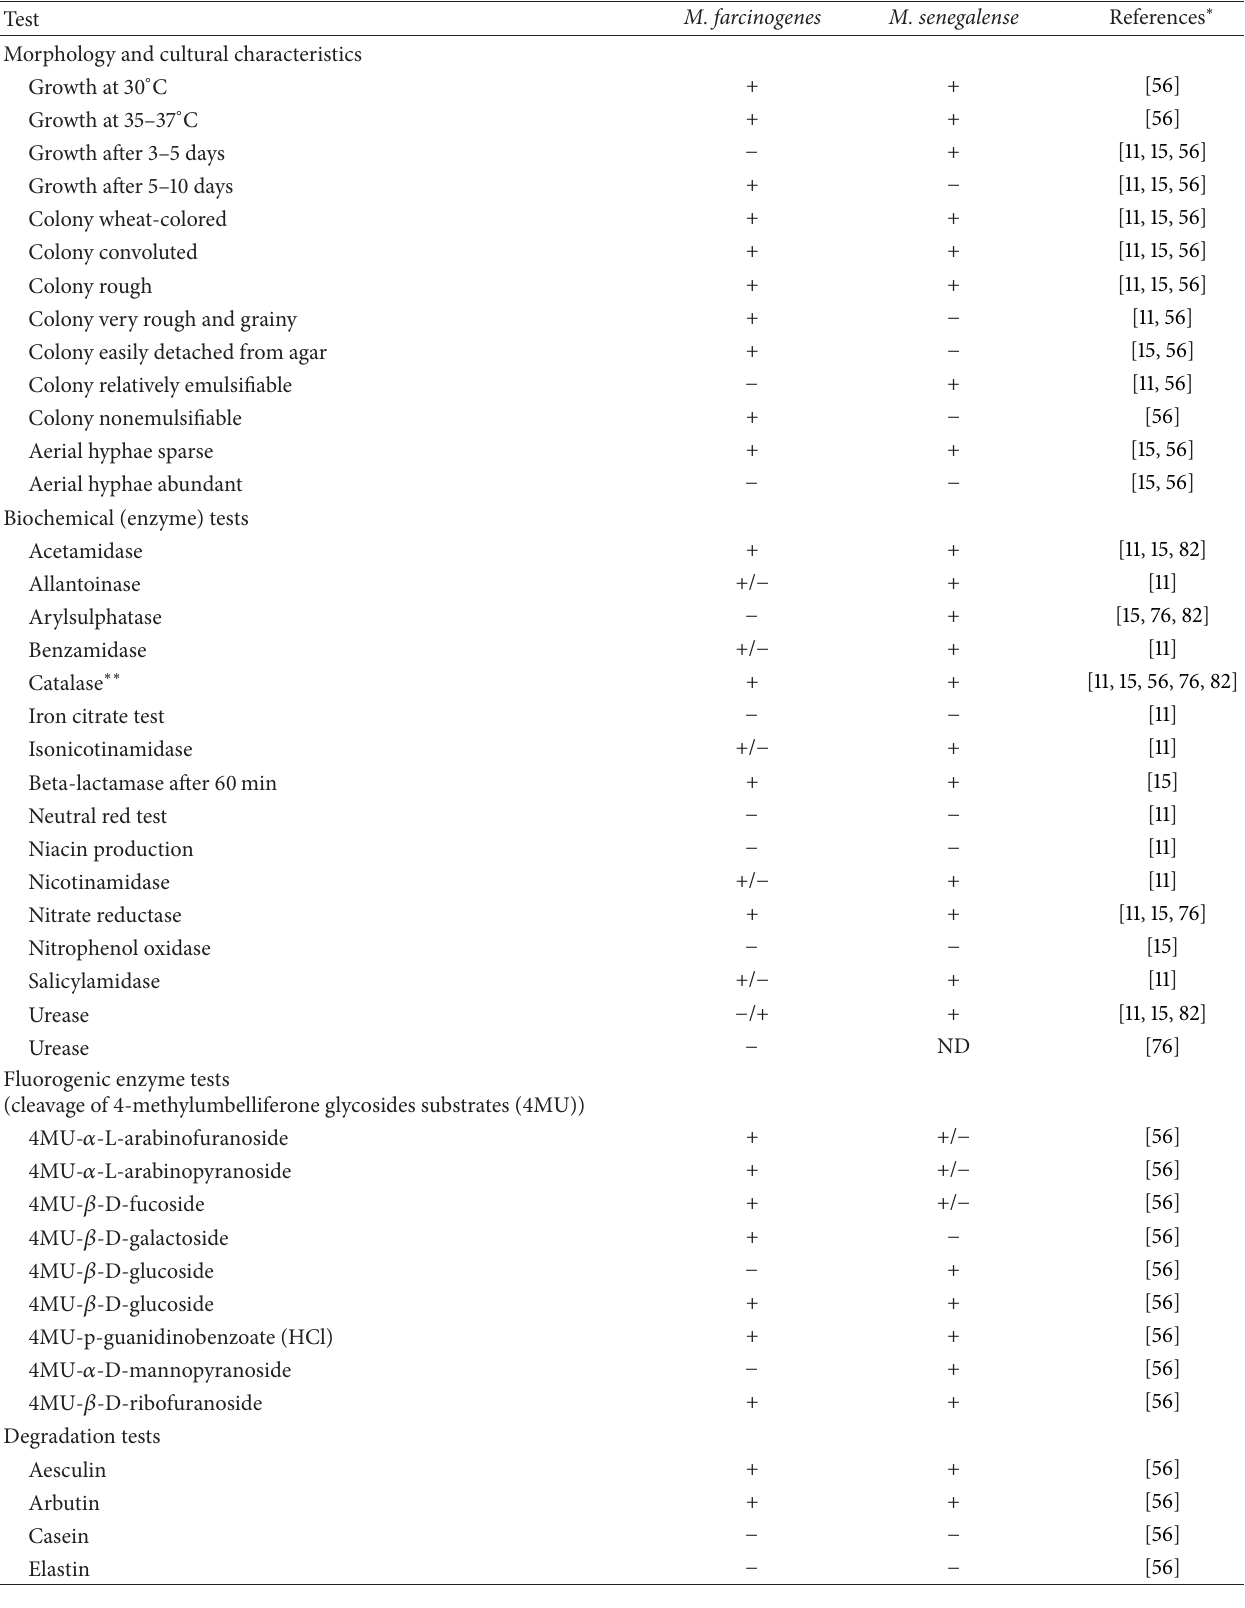
Table 1: Phenotypic characteristics of Mycobacterium farcinogenes and Mycobacterium senegalense .